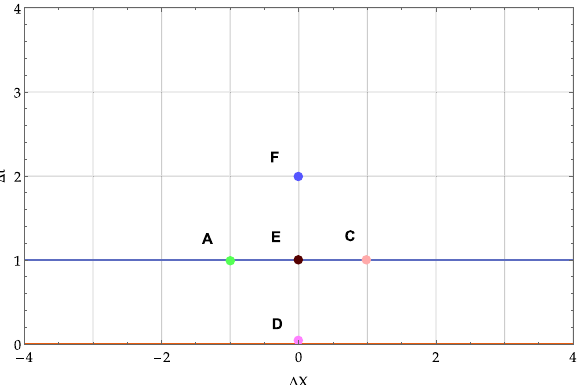
Fig. 11 ( x − t ) plane for Integration scheme